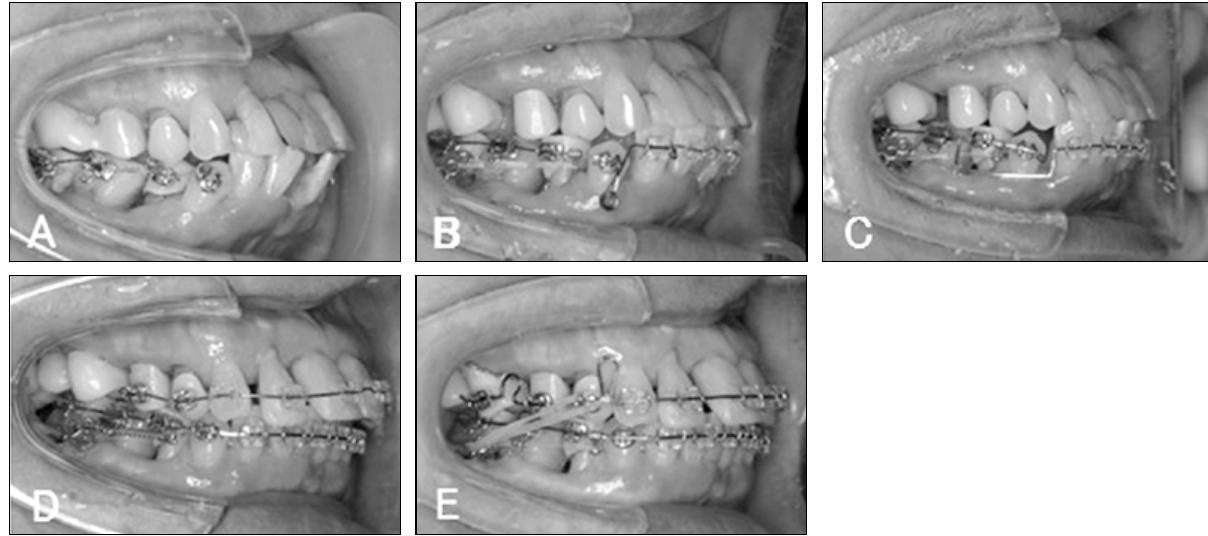
Figure 5. Intraoral photographs showing various orthodontic apparatus applied during each step of orthodontic